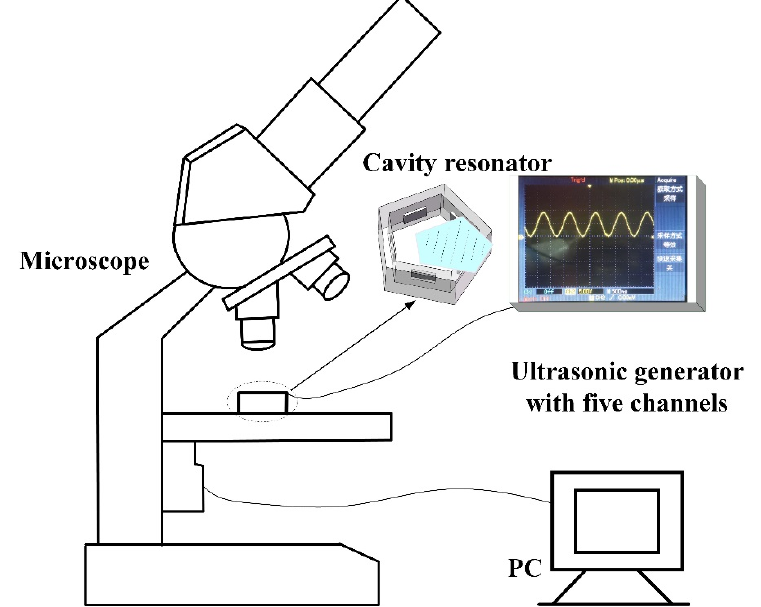
Figure 1. Ultrasonic array, sound pressure, micro-potential, well cell, non-contact manipulation experimental system.